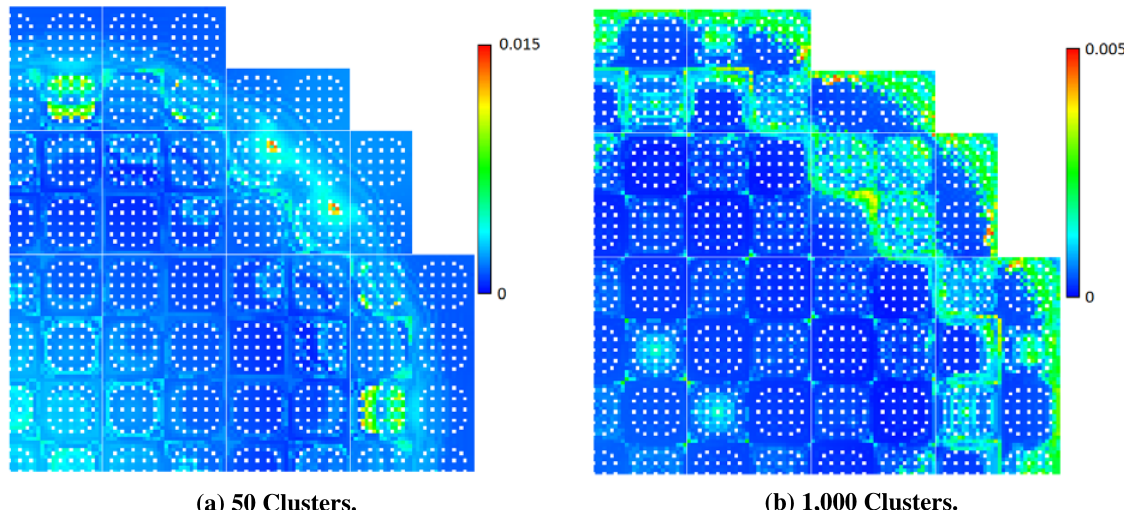
(a) 50 Clusters. (b) 1,000 Clusters. Figure 5: Relative standard deviation of the pin fission density using 50 and 1,000 clusters and a sample size of